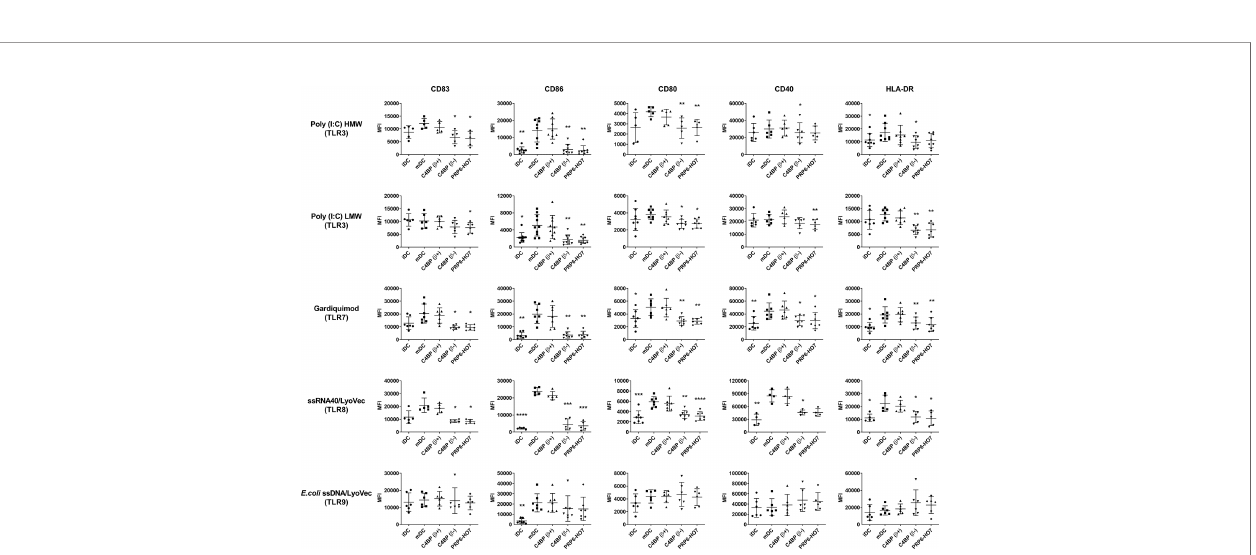
FIGURE 5 | PRP6-HO7 prevents pro-in fl ammatory surface TLR activation of Mo-DCs. Human Mo-DCs were incubated throughout their differentiation process with C4BP( b +), C4BP( b -) (both at 12 nM) and PRP6-HO7 (32 nM). DC maturation was achieved by TLR agonist treatment: Pam3CSK4 (TLR1/2), HKLM (TLR2), LPS-EK (TLR4), FLA-ST (TLR5), FSL-1 (TLR6/2). Cells were then collected, washed, and analyzed by fl ow cytometry for cell surface expression of CD83, CD86, CD80, CD40 and HLA-DR. MFI, median fl uorescence intensity for the different surface markers. iDC, untreated, immature DCs; mDC, untreated, TLR-matured DCs. The results shown are the mean ± SD from 4-8 independent donors (*, p < 0.05; **, p < 0.01; ***, p < 0.001 compared with mDC).